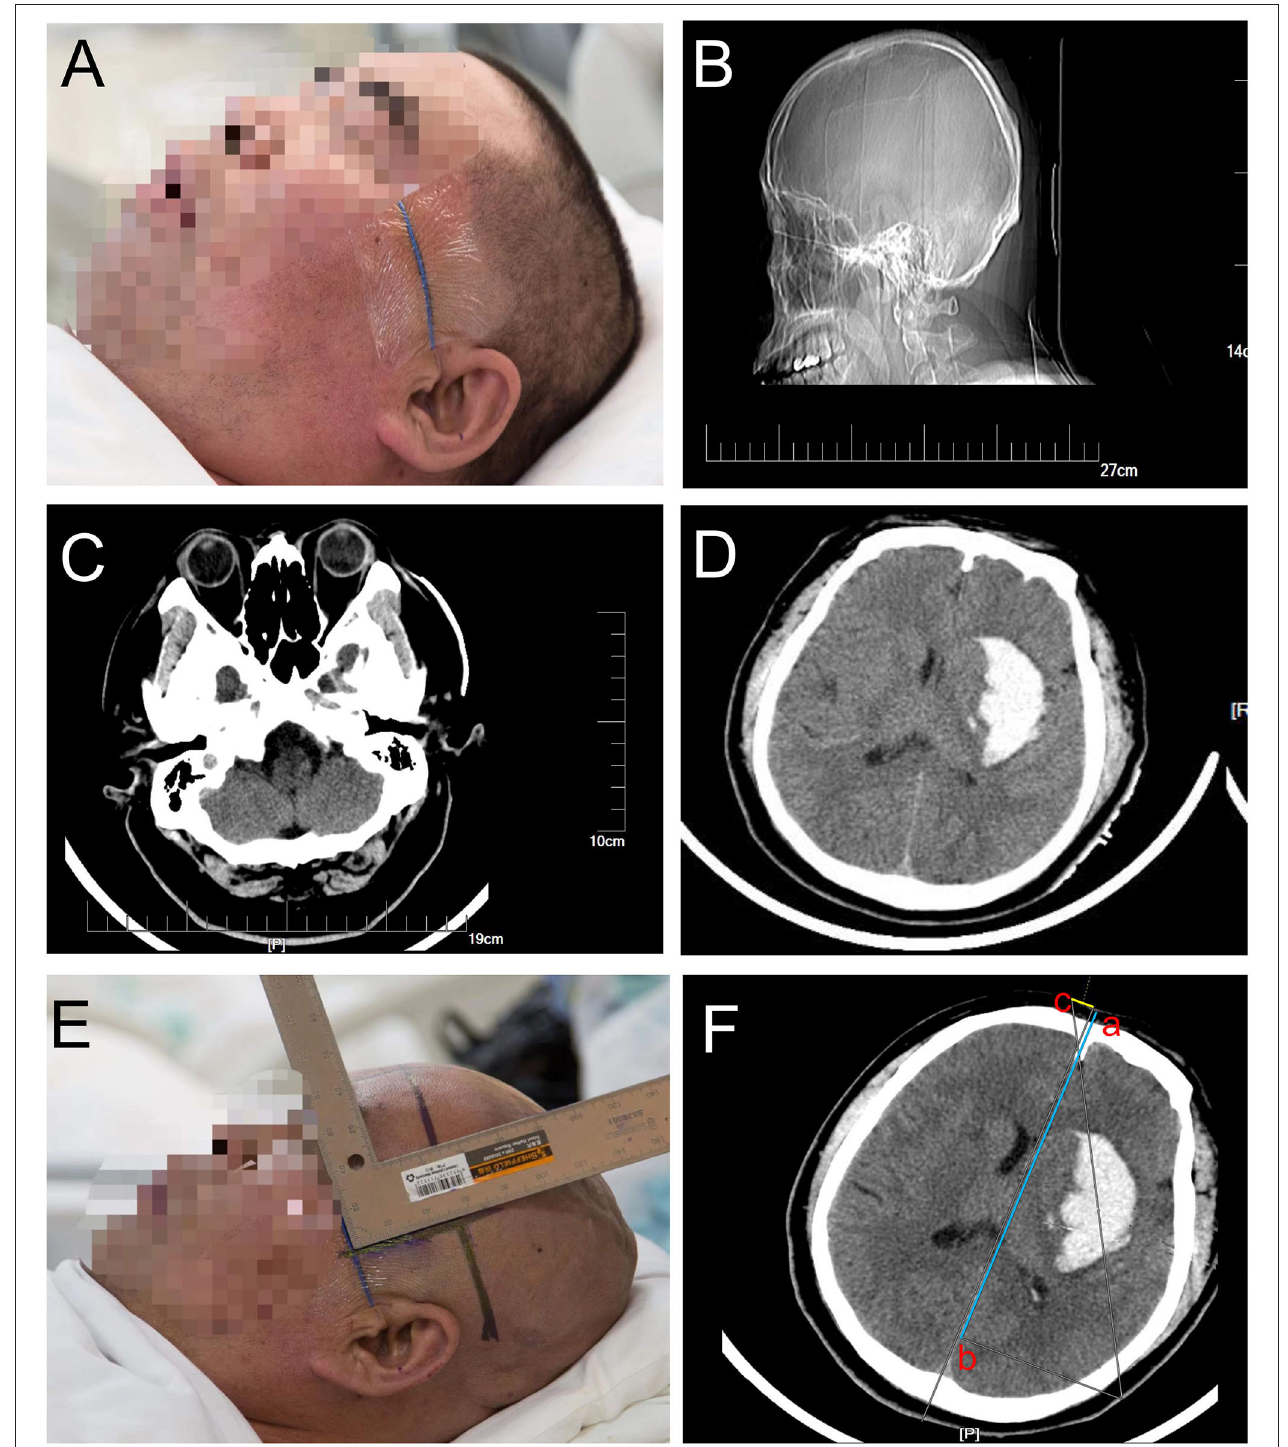
FIGURE 2 | (A) shows that the orbitomeatal line is the preparation before the CT scan for patients with suspected cerebral hemorrhage, (B) confirms that the orbitomeatal line was precisely attached to the scalp, (C) represents the slice marked by the orbitomeatal line as the first slice of the CT scan, intracranial hemorrhage was confirmed in (D) , and the punctured plane was measured based on the distance between the first slice and the largest slice of the hematoma in (E) . (F) represents how to determine the position of the location stickers on the CT image by measuring and marking their positions on the scalp.